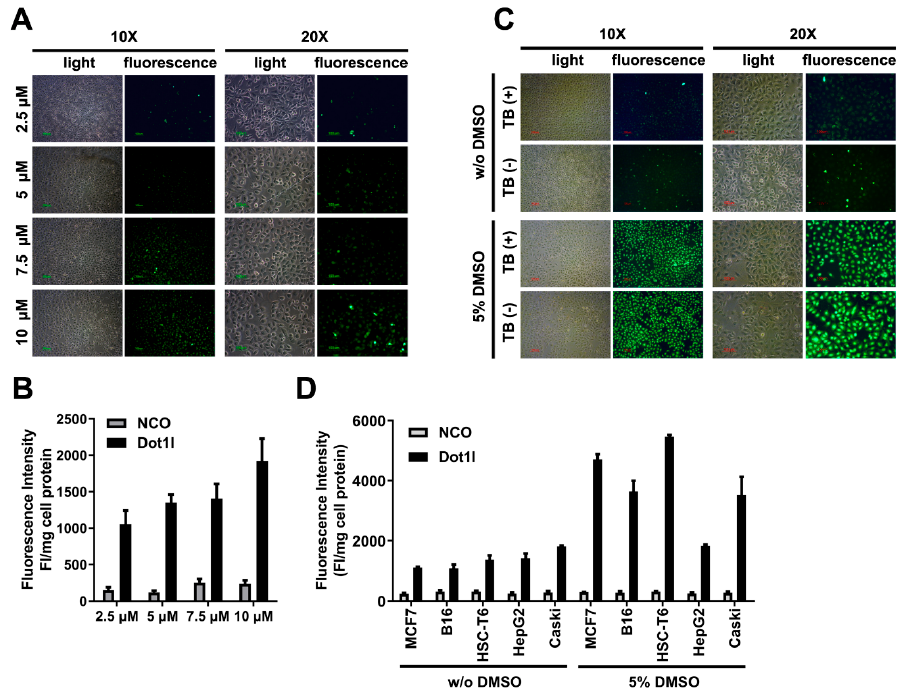
Figure 2. Fluorescence labelled Dot1l peptide penetration in cultured cells. ( A ) Fluorescence microscopy of fluorescein isothiocyanate (FITC)-labeled Dot1l peptide with different concentrations. ( B ) Quantization analysis of FITC-labeled Dot1l peptide corresponding to fluorescence microscopy with di ff erent concentration measurements. The statistical analysis is shown in Supplementary Figure S1A. ( C ) Fluorescence microscopy of FITC-labeled Dot1l peptide with or without trypan blue incubation in the DMSO-pretreated or control group. ( D ) FITC-labeled Dot1l peptide penetration in di ff erent cell lines (MCF7, B16, HSC-T6, Caski, and HepG2) with or without DMSO pretreatment. The